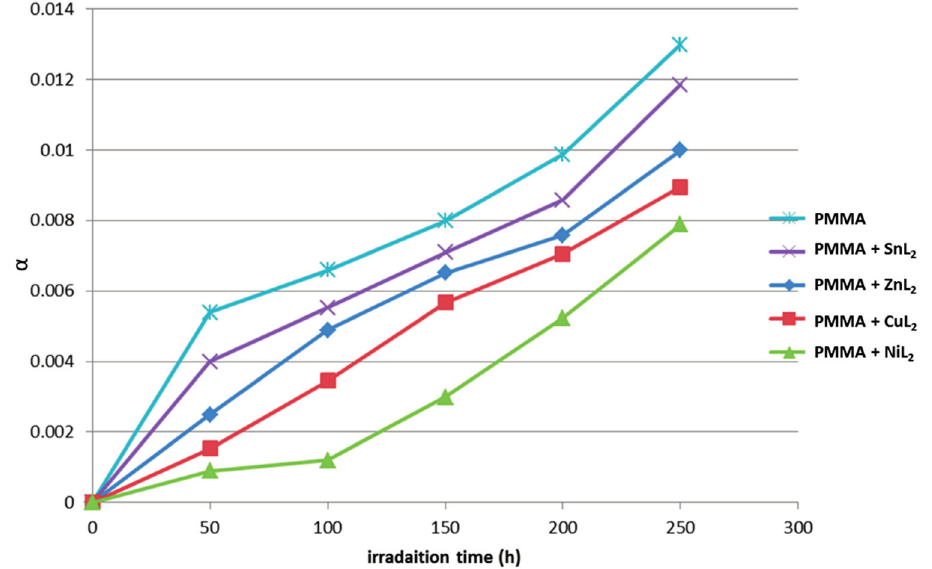
Figure 12. Changes in the degree of deterioration ( α ) during irradiation of PMMA films (40 μ m; control) and additives (0.5% by